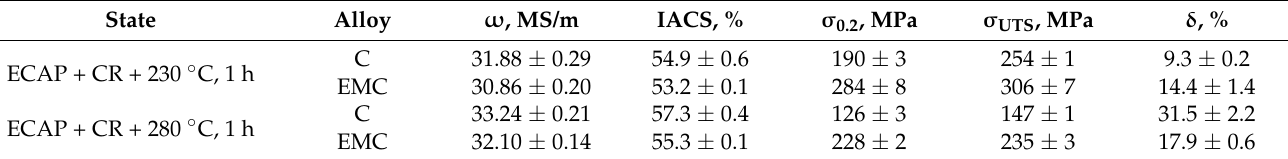
Table 5. Physical and mechanical properties of the UFG CC and EMC alloys after thermal stabil- ity tests.